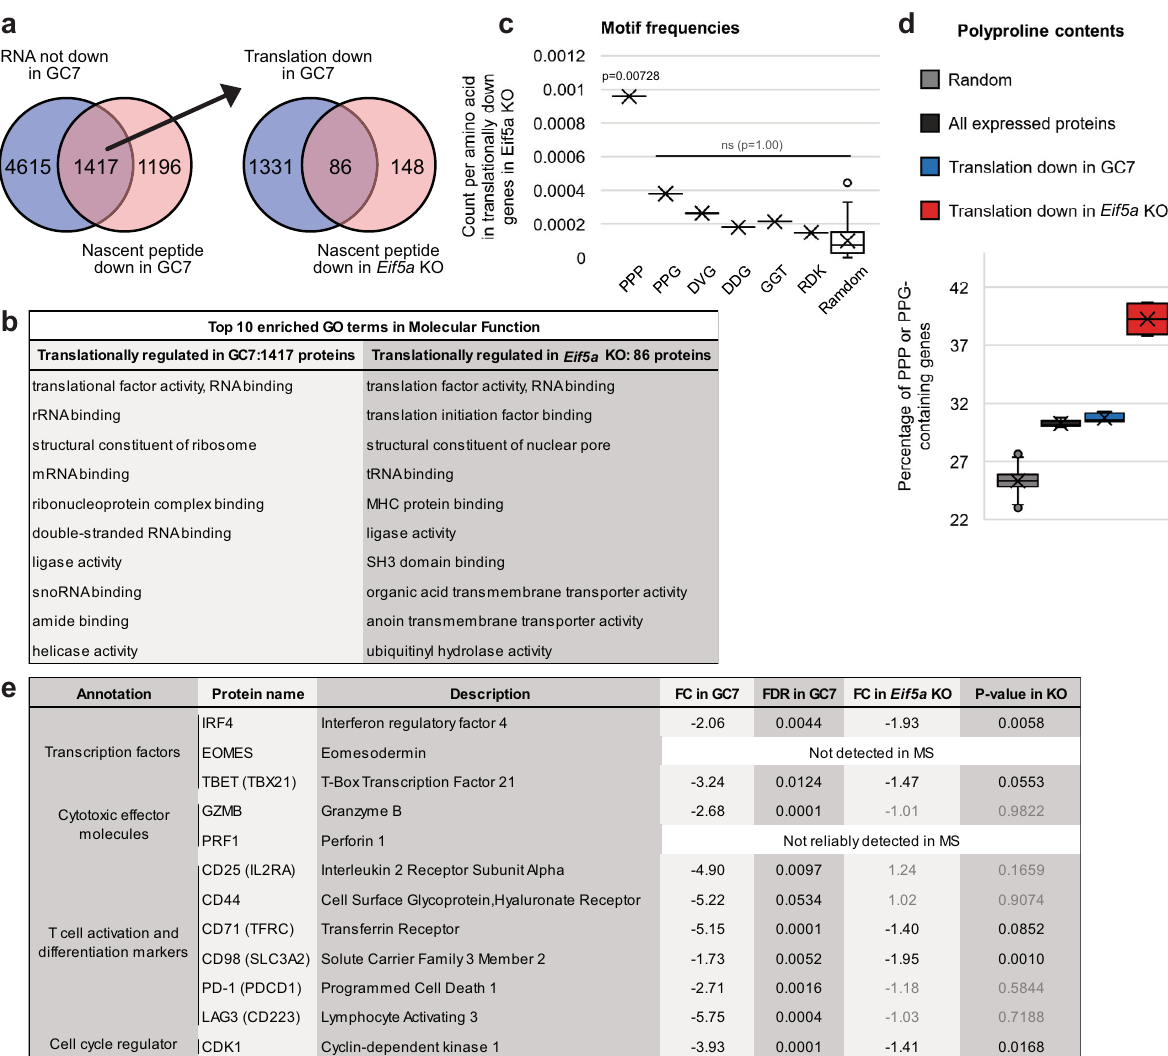
Fig. 5 | Identi fi cation of translationally regulated genes affected by GC7 treat- ment and Eif5a KO.a Venn diagramoverlaysidentify1417proteinsnot reduced in their mRNA (FDR>0.1 or FDR<0.01 and FC>2, edgeR, n =4, red dots in Supple-